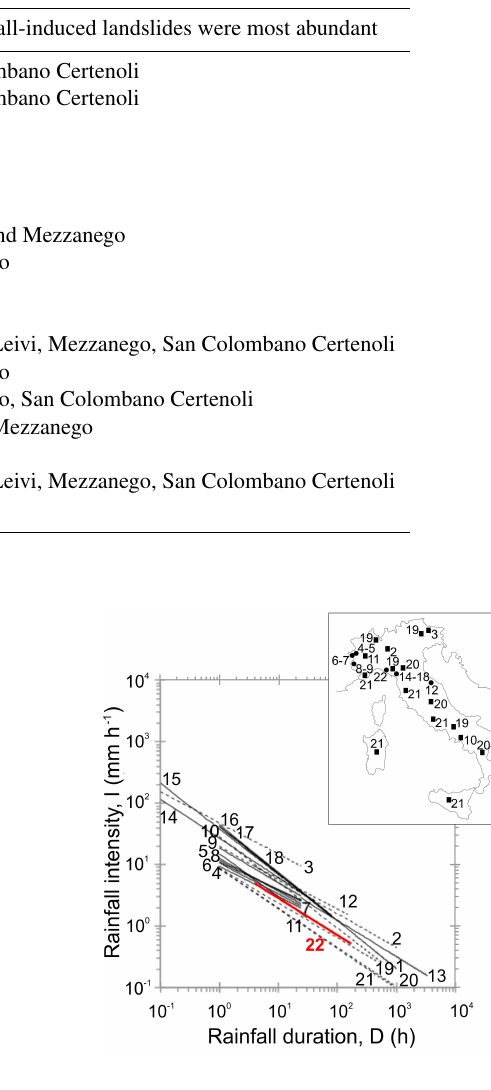
Figure 9. (a) Comparison between the ID threshold defined for the Entella catchment and threshold curves available in literature for regions, individual catchments and local areas in Italy (Table 6). Plot is in logarithmic coordinates. Dashed black lines show regional thresholds and continuous black lines show local thresholds. Red line (22) shows the rainfall threshold defined in this work for the Entella catchment. Sources: 1 – Cancelli and Nova (1985); 2 – Ce- riani et al. (1994); 3 – Paronuzzi et al. (1998); 4–9 – Bolley and Ol- liaro (1999); 10 – Calcaterra et al. (2000); 11 – Marchi et al. (2002); 12 – Aleotti (2004); 13 – Floris et al. (2004); 14–15 – Giannec- chini (2005); 16–18 – Gianecchini et al. (2012); 19–21 – Peruccacci et al. (2017). (b) Location map shows sites for which the threshold curves were defined: dots are threshold curves for individual catch- ments and local areas, squares are regional threshold